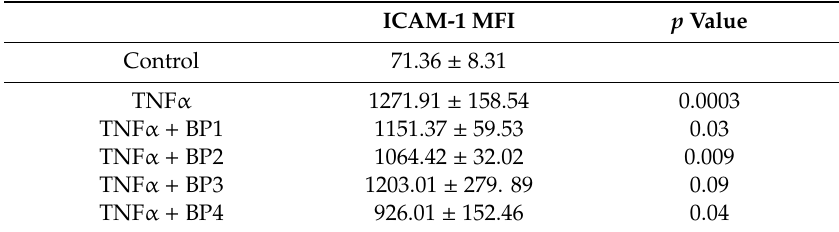
Table 2. Mean fluorescence intensity (MFI) of ICAM-1 surface expression in inflammatory conditions measured by flow